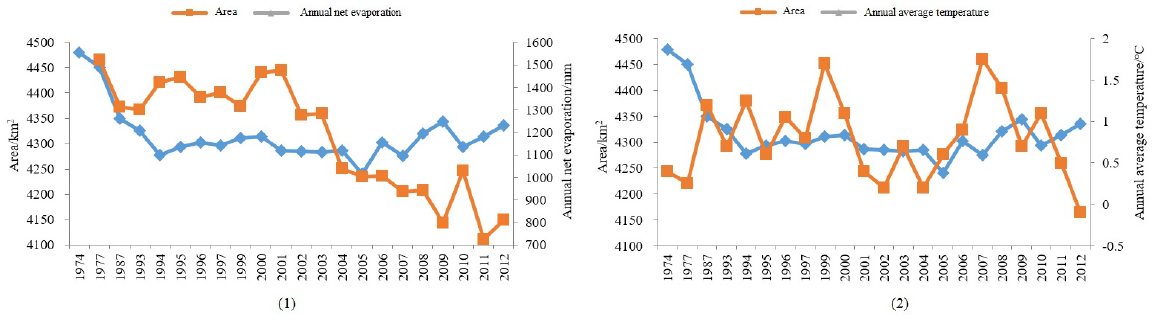
Figure 6. Comparison of area of Qinghai Lake and (2) annual average temperature (1) annual net